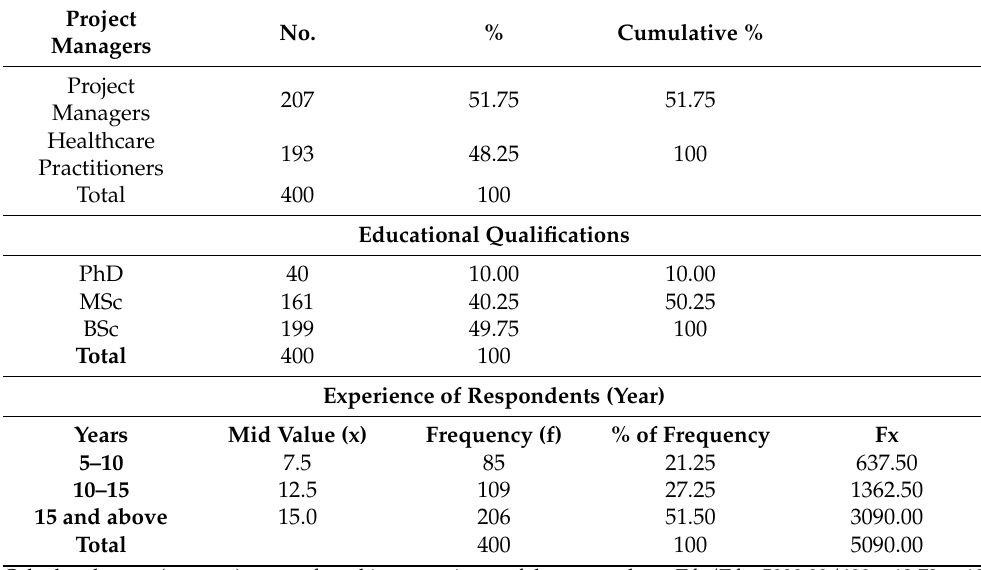
Table 2. Information on respondents’ demography.